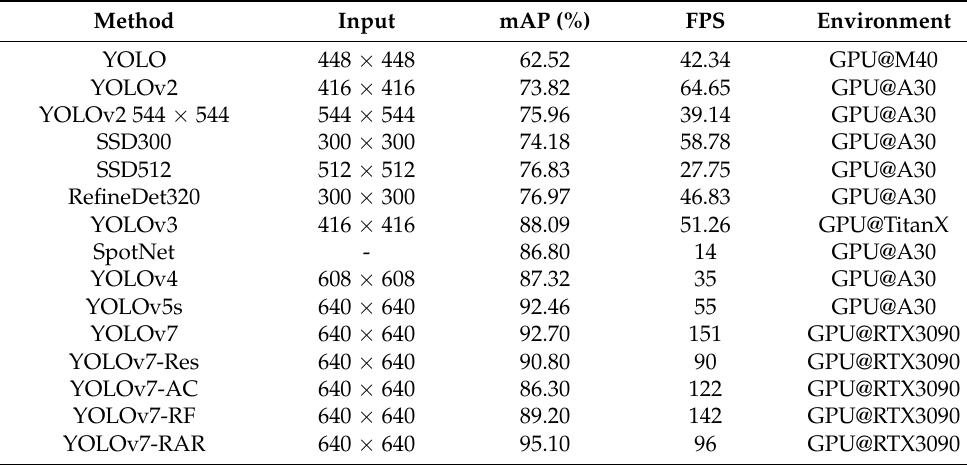
Table 7. Some excellent algorithms are selected to be compared with our